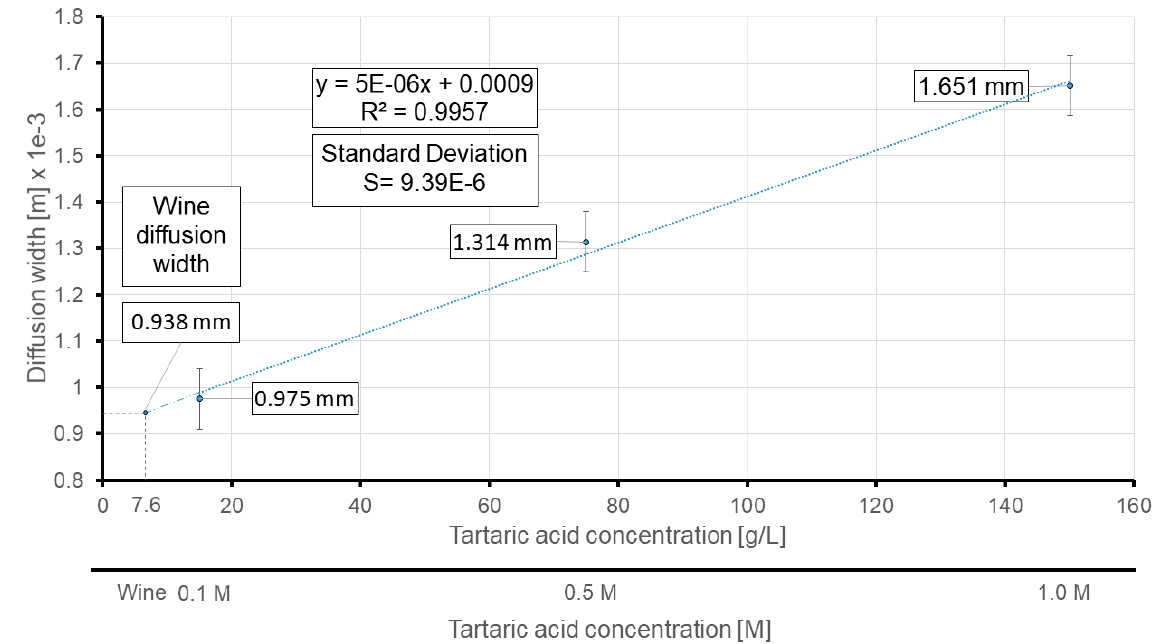
Figure 13. Calibration plot based on the average measured diffusion widths at the new measurement line (neck of the 30-degree model). The predicted concentration of wine is also displayed via extrapolation of the regression line. The units are in millimeters.